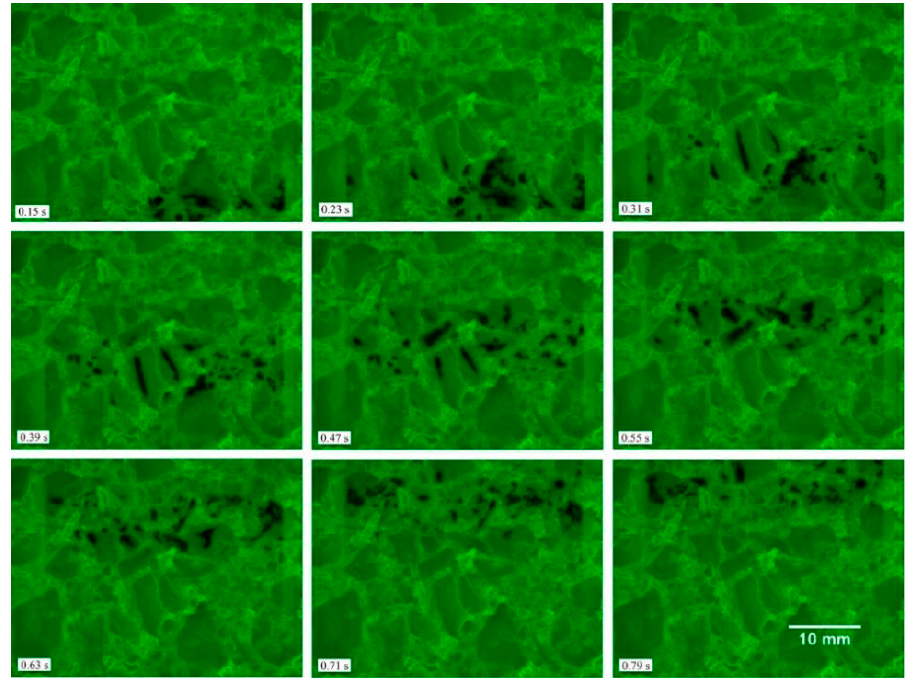
Figure 10. The images of rubber-wheel contact while running at moving speed 40 mm/s under 40.2 N of the normal load.